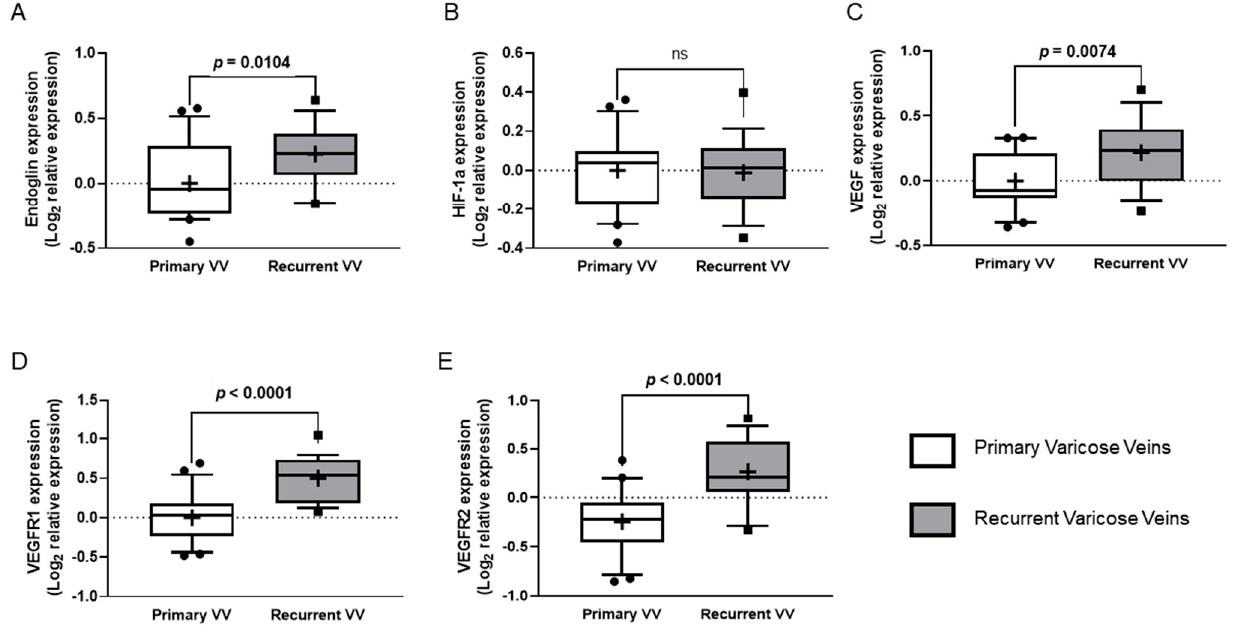
Figure 2. Expression of angiogenesis-related genes in proximal samples. ( A – E ) Quantitative analysis of expression of the genes investigated in samples of the proximal great saphenous vein (tissue obtained during surgery) was performed by quantitative RT-PCR. Relative expression of Eng: en- doglin ( A ), HIF1A: hypoxia-inducible factor 1A ( B ), VEGFA: vascular endothelial growth factor A ( C ), VEGFR1: vascular endothelial growth factor receptor 1 ( D ) and VEGFR2: vascular endothelial growth factor receptor 2 ( E ) in recurrent varicose vein vs primary varicose vein were analysed. For data normalisation, qPCR analyses are represented as logarithmic transformation of the relative ex- pression; box plots show median and 25–75 percentiles, and whiskers show 10–90 percentile. The p - value obtained after t-test analysis indicated if it is statistically significant. ns: not significant.